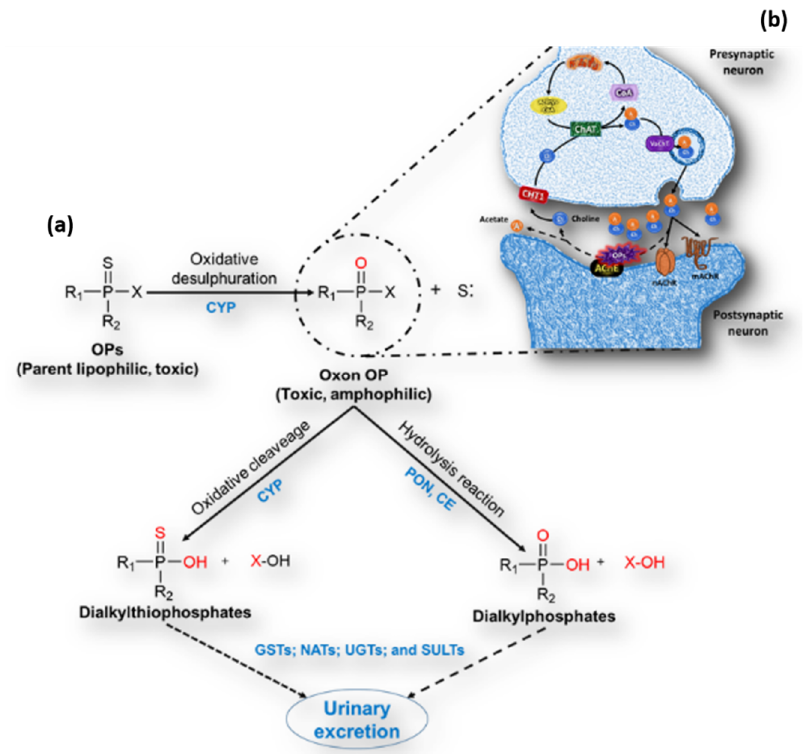
Figure 1. General metabolic pathway of organophosphate pesticides with the neurotoxic mechanism of action. ( a ) The parent organophosphorothionates bioactivated to highly toxic oxon forms by cytochrome P450 through the removal of sulfur attached to phosphorus and insertion of the oxygen atom (oxidative desulphuration) using the reactive and electrophilic iron–oxo intermediate, detoxified by dearylation to form dialkyl thiophosphates (inactive metabolites) or further hydrolyzed to dialkyl phosphates (inactive metabolites) by paraoxonase-1 (PON1) and carboxylesterase (CE) in phase I. Furthermore, phase II involves conjugative reactions carried out by glutathione transferases (GSTs); N-acetyltransferases (NATs); UDP-glucuronosyltransferase (UGTs); and sulphotransferases (SULTs), UDP-glucuronyltransferases (UGT), sulphotransferases (SULT), N-acetyltransferases (NAT), glutathione S-transferases (GST); and is excreted out through urine in a nontoxic form. ( b ) The oxon metabolite phosphorylates the hydroxyl group of the serine present in the active site of the enzyme acetylcholinesterase (AChE) causing ACh accumulation in the nerve synapsis